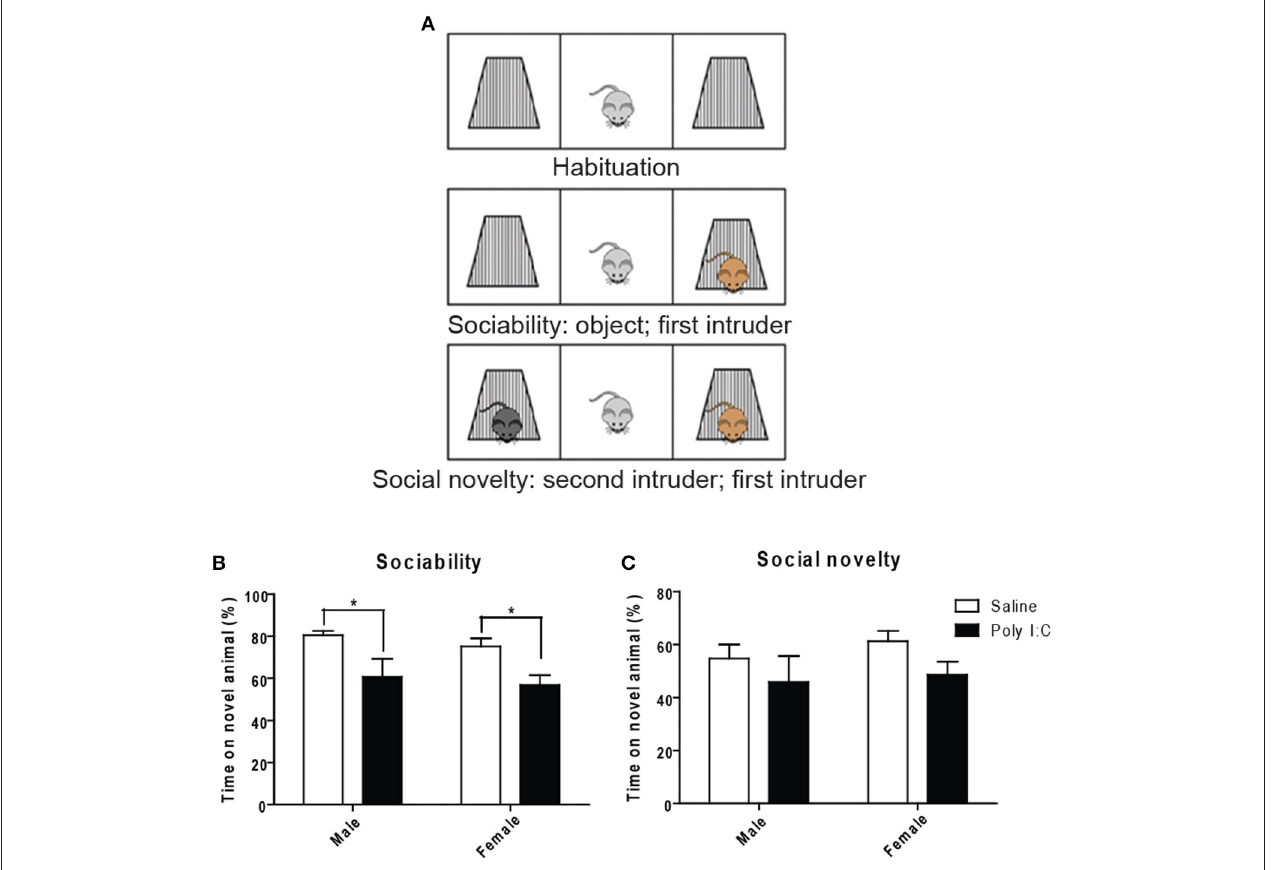
FIGURE 5 | Effects of Poly I:C on sociability and social novelty assessed with the three-chambered social interaction test. (A) Schematic representation of the procedure for testing (modified from http://med.stanford.edu). Quantification of sociability is shown in (B) and social novelty is shown in (C) . n = 6–8 mice per sex and group. * p < 0.05.